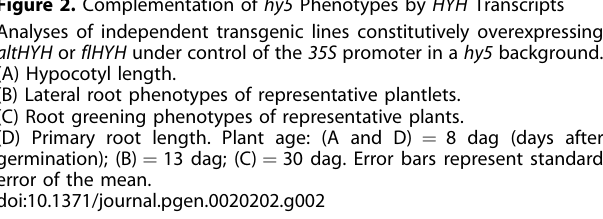
Figure 2. Complementation of hy5 Phenotypes by HYH Transcripts Analyses of independent transgenic lines constitutively overexpressing altHYH or flHYH under control of the 35S promoter in a hy5 background. (A) Hypocotyl length. (B) Lateral root phenotypes of representative plantlets. (C) Root greening phenotypes of representative plants. (D) Primary root length. Plant age: (A and D) ¼ 8 dag (days after germination); (B) ¼ 13 dag; (C) ¼ 30 dag. Error bars represent standard error of the